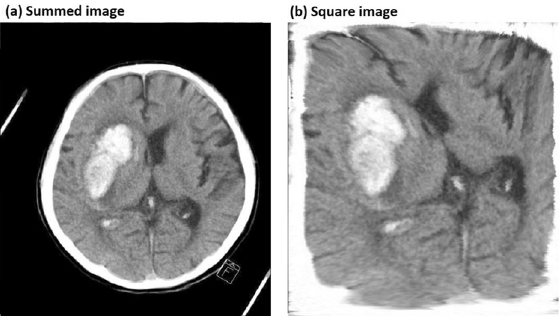
Figure 1. Example of CT image processing for preparing image data. ( a ) Summed image of a subdivision for a case. ( b ) Square image expanded to fit in a square.